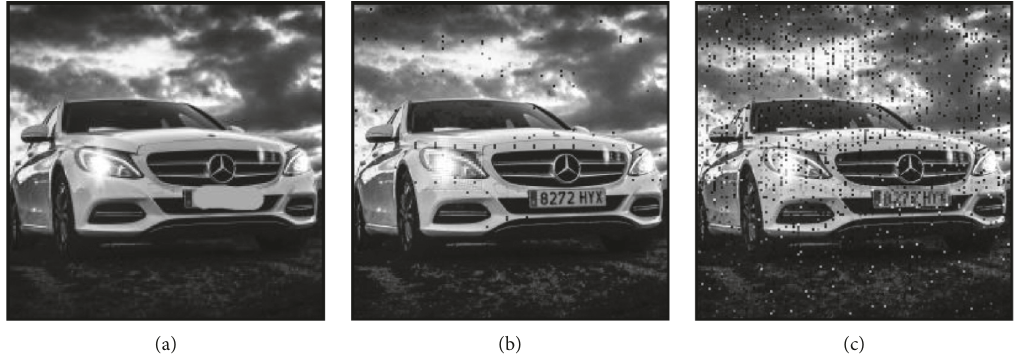
Figure 12: (a) Image after removing the car number. (b) Using perceptual and (c) without using perceptual map with intensity �